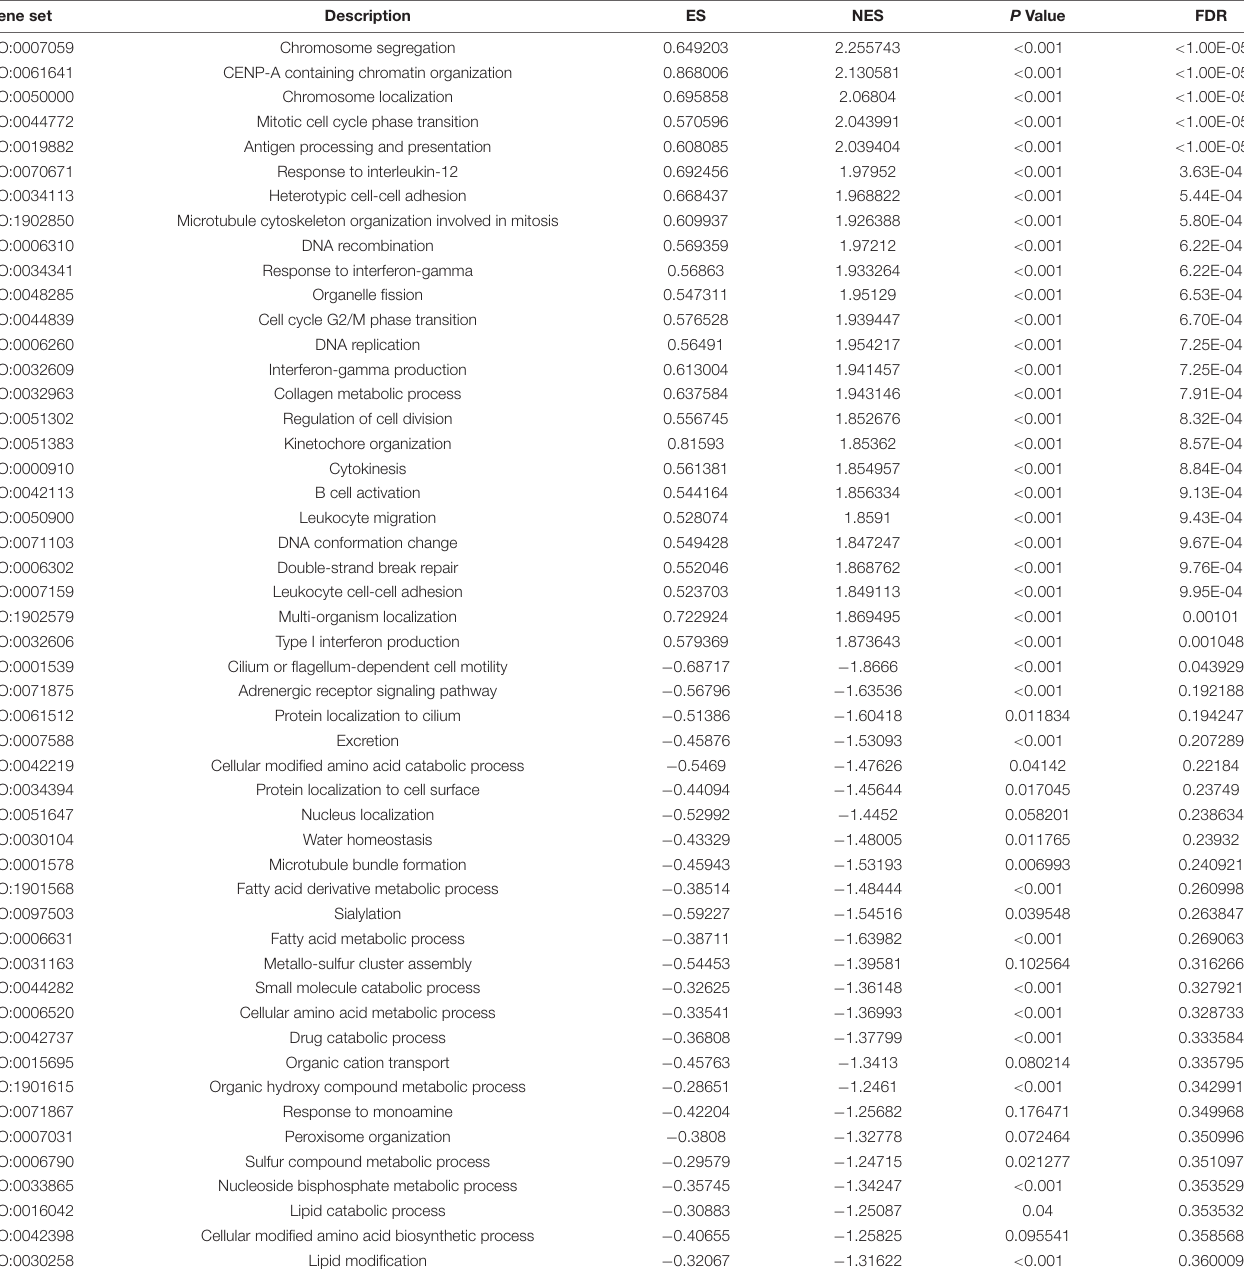
TABLE 1 | GSEA result for GO